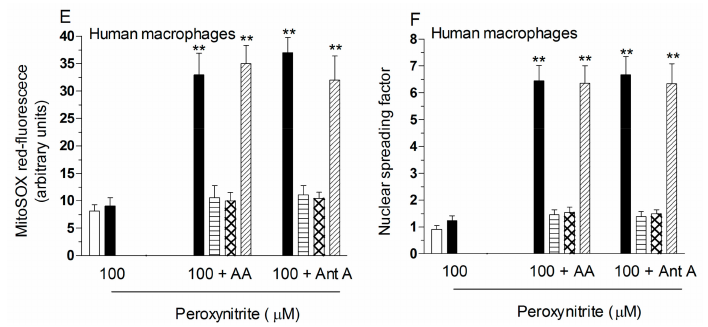
Figure 2. The enhancing effects of AA are also observed in human monocytes or macrophages exposed to peroxynitrite. Human monocytes were pre-exposed for 15 min to increasing concentrations of AA and then treated for a further: 10 min ( A ); or 30 min ( B ) with 100 µ M peroxynitrite. After treatments, the cells were analyzed for: MitoSOX red-fluorescence ( A ); and DNA damage ( B ). Results represent the means ± SD calculated from at least three separate experiments using monocytes from three different donors. * p < 0.01 or ** p < 0.001 as compared to untreated cells (two-way ANOVA followed by Bonferroni’s test). Human monocytes ( C , D ); or macrophages ( E , F ) were pre-exposed for 15 min to 100 µ M AA, or for 5 min to antimycin A (Ant A), and then treated for a further: 10 min ( C , E ); or 30 min ( D , F ) with 100 µ M peroxynitrite. In some experiments, rotenone, myxothiazol, or Ry, were given to the cultures prior to peroxynitrite. After treatments, the cells were analyzed for: MitoSOX red-fluorescence ( C , E ); and DNA damage ( D , F ). Results represent the means ± SD calculated from at least three separate experiments using monocytes (or monocyte-derived macrophages) from three different donors. ** p < 0.001 as compared to untreated cells (one-way ANOVA followed by Dunnett’s